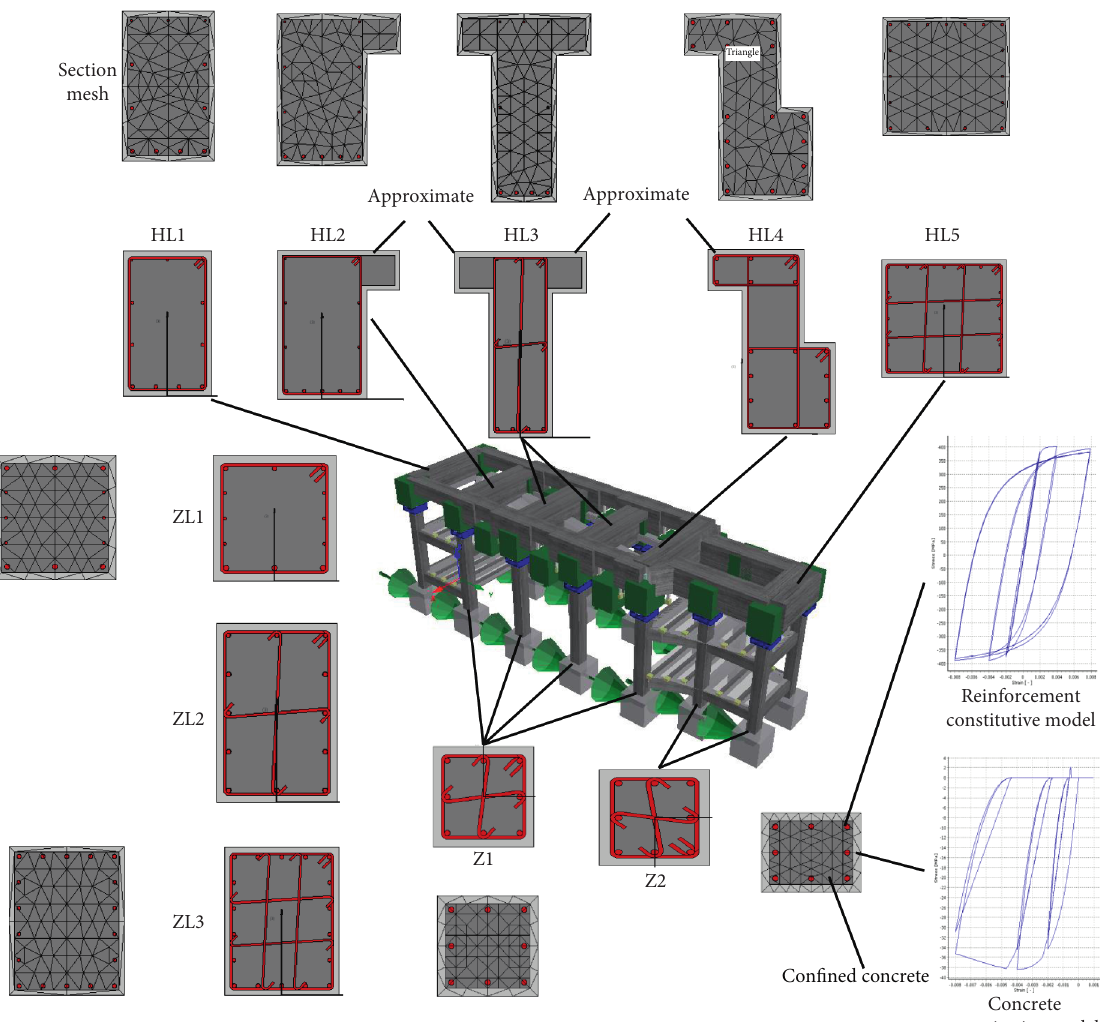
Figure 10: Model established by SeismoStruct and section